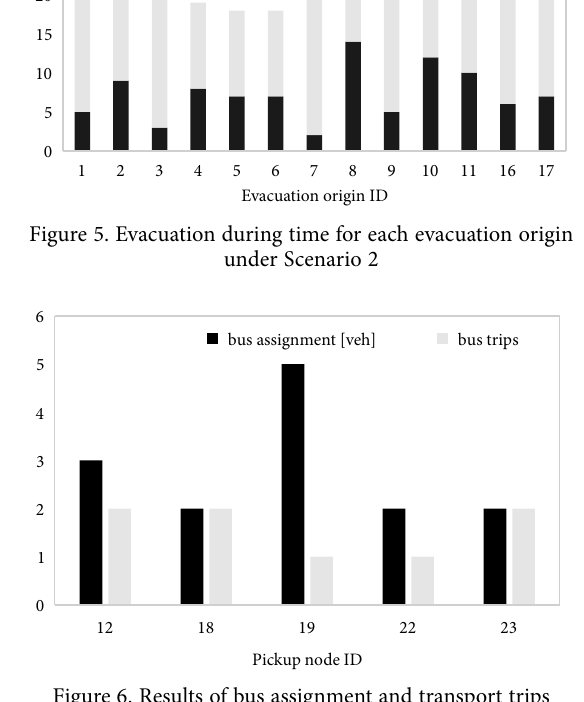
Figure 6. Results of bus assignment and transport trips under Scenario 2